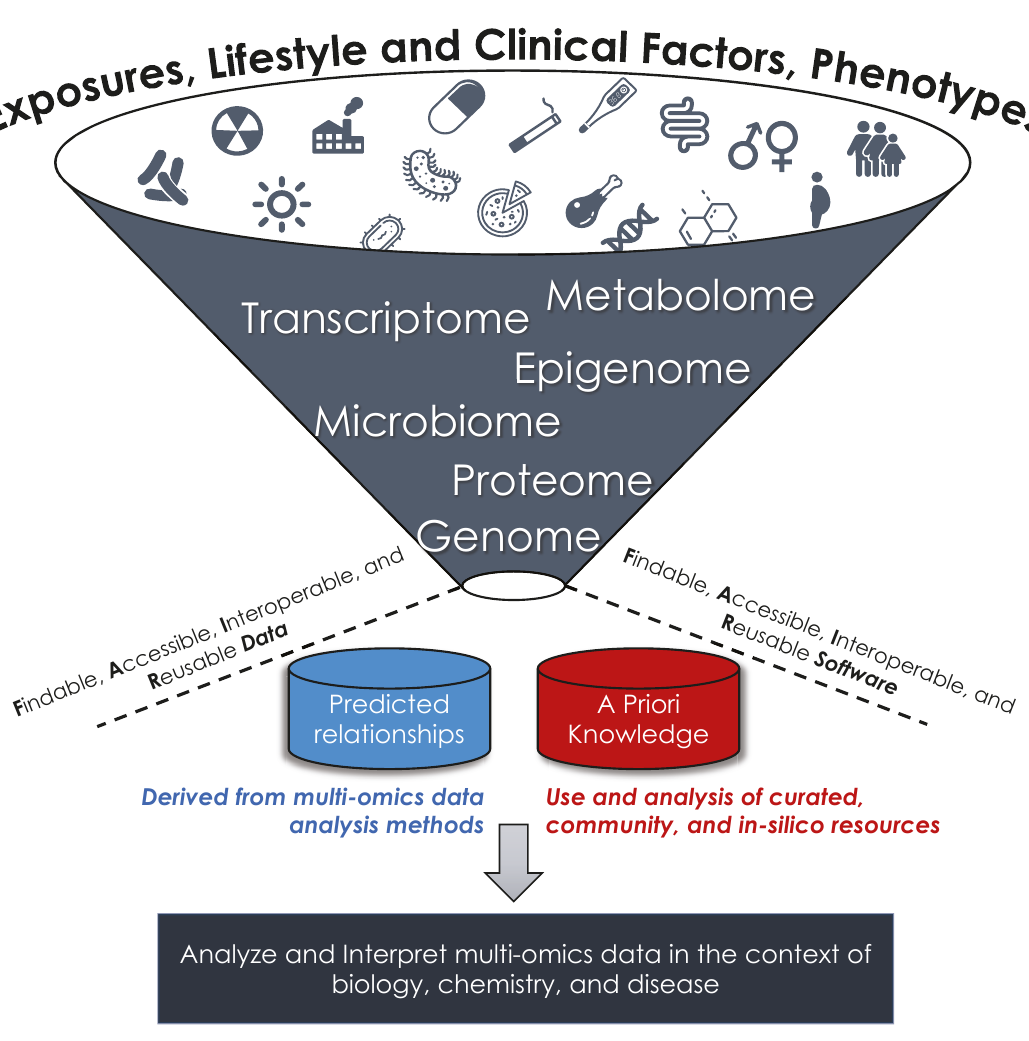
Figure 1. The metabolome in the context of other omics data types and broad approaches for their